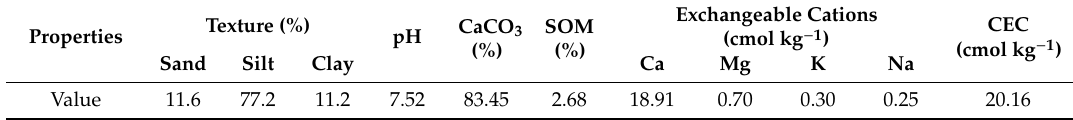
Table 1. General soil properties of the study location. Abbreviations: carbonates (CaCO 3 ), soil organic matter (SOM), calcium (Ca), magnesium (Mg), potassium (K), sodium (Na), and cation exchange capacity